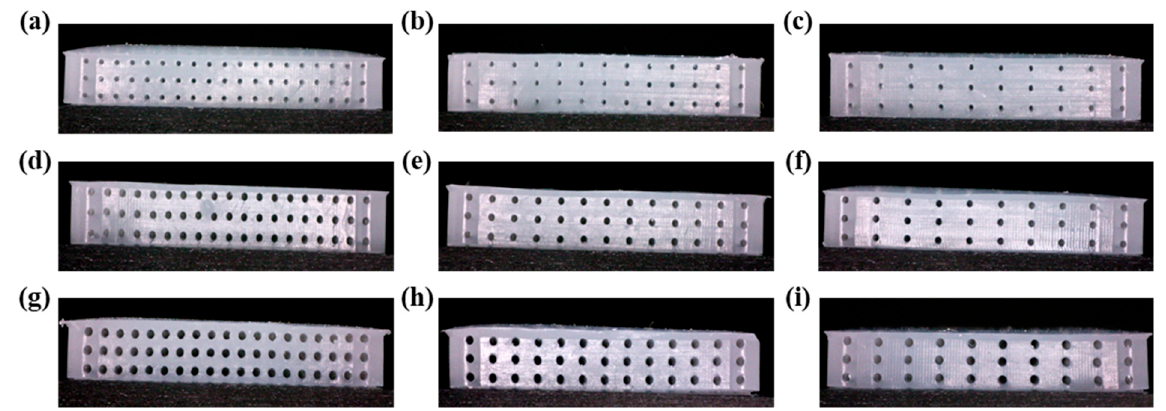
Figure 3. Cross-sectional images of the alignment airgap dielectric layer. ( a – c ) pore size: 300 μ m, distance: 1 mm, 1.5 mm, 2 mm. ( d – f ) pore size: 400 μ m, distance: 1 mm, 1.5 mm, 2 mm. ( g – i ) pore size 500 μ m, distance: 1 mm, 1.5 mm, 2 mm. Table 1. Porosity of the dielectric layers for different sizes and spacing.